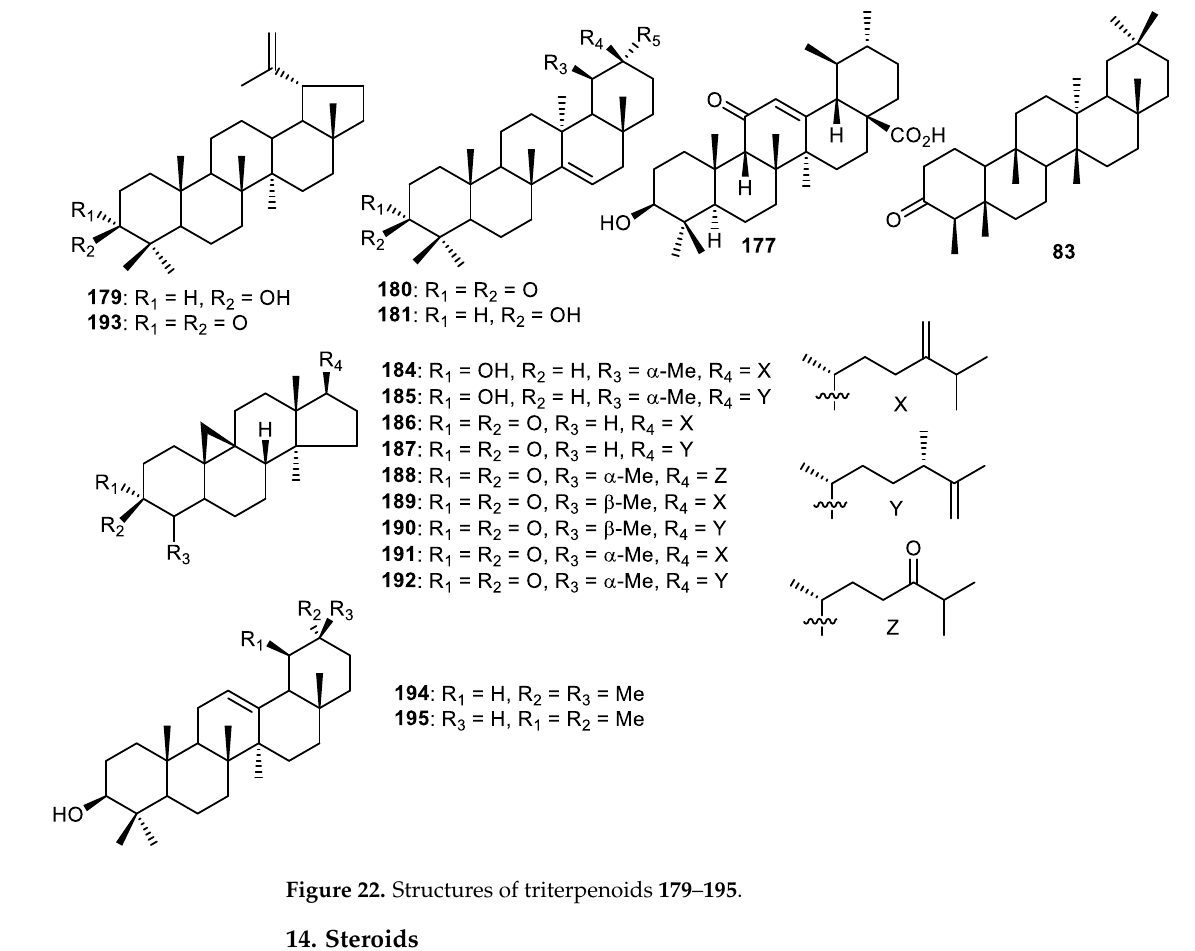
Figure 22. Structures of triterpenoids 179 – 195